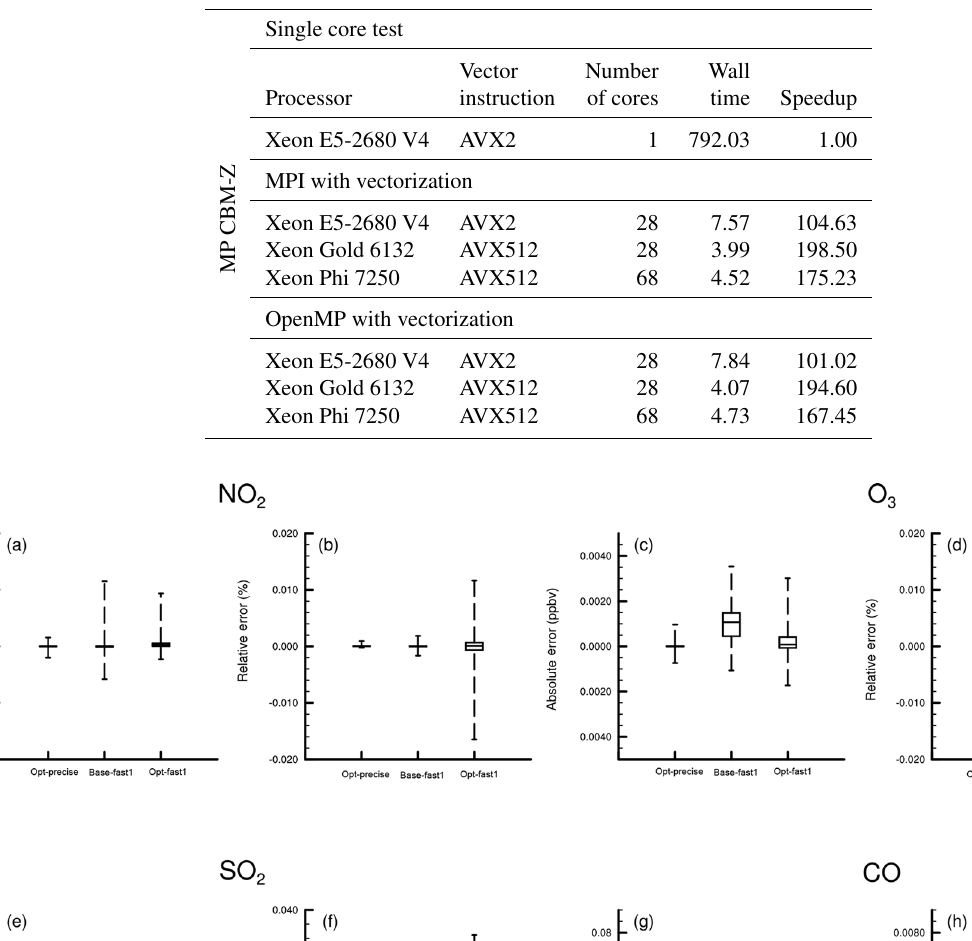
Table 5. The performance tests of the optimized code on different CPUs and KNL platforms with MPI and OpenMP. The unit of the wall times for the tests is seconds (s).